Question: Generate an informative caption for the figure above.
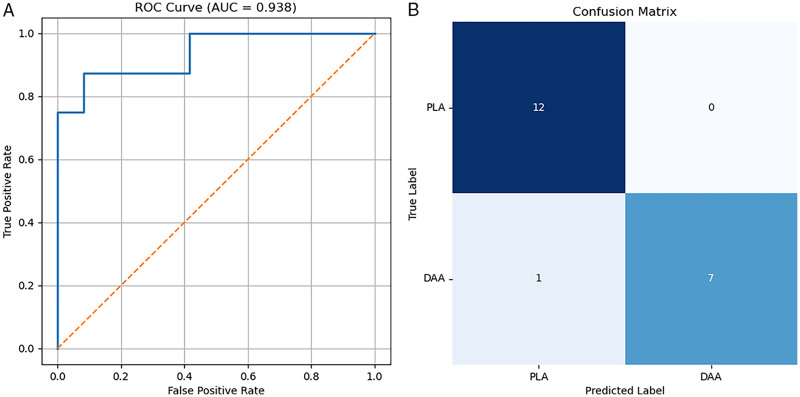
Answer: (A,B) ROC curve and model confusion matrix diagram.